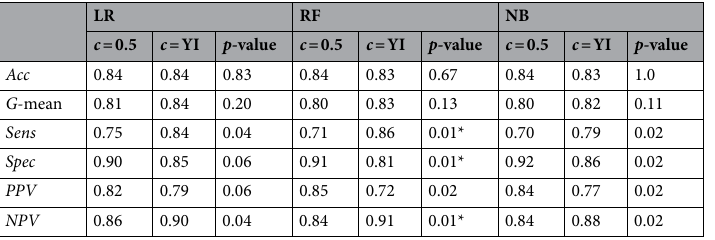
Table 4. Comparison of operating characteristics mean values, as obtained using the default cut-off value c = 0.5 or the value obtained by maximizing YI, among each classification method. YI Youden index, Acc accuracy, Sens sensitivity, Spec specificity, PPV positive predictive value, NPV negative predictive value, LR logistic regression, RF random forest, NB naive Bayes. *Still significant for p < 0.05 after applying Bonferroni correction for multiple